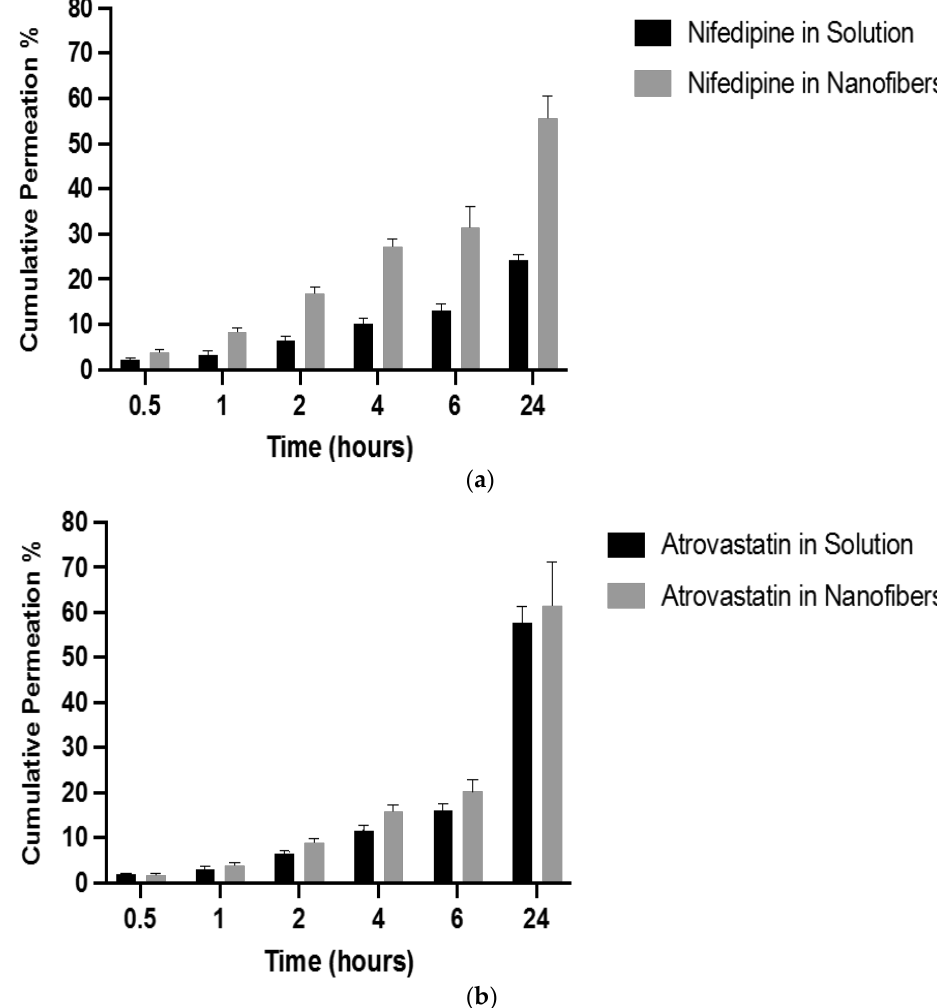
Figure 7. The permeability of ( a ) nifedipine and ( b ) atorvastatin calcium in drug-loaded nanofibers and in drug solution form. The results showed a significantly enhanced permeability ( p < 0.05) for both drugs from the nanofibers compared to the solution form—results represented as mean ± SD ( n = 3).